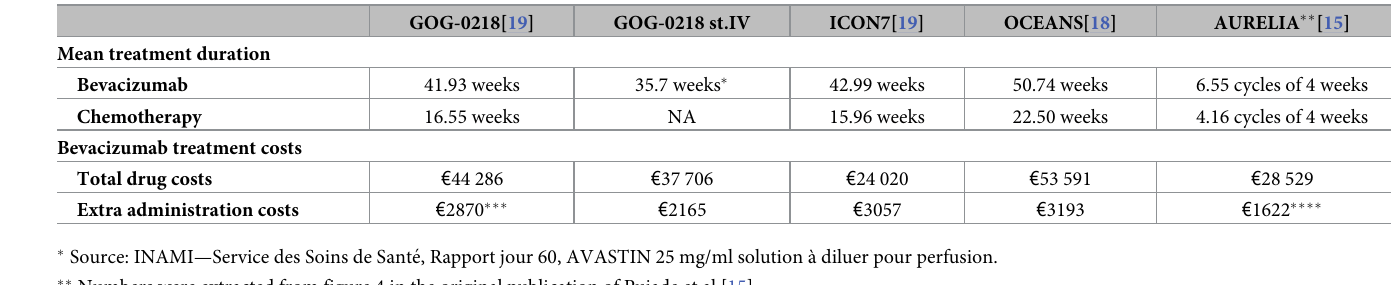
Table 4. Mean treatment duration and bevacizumab treatment